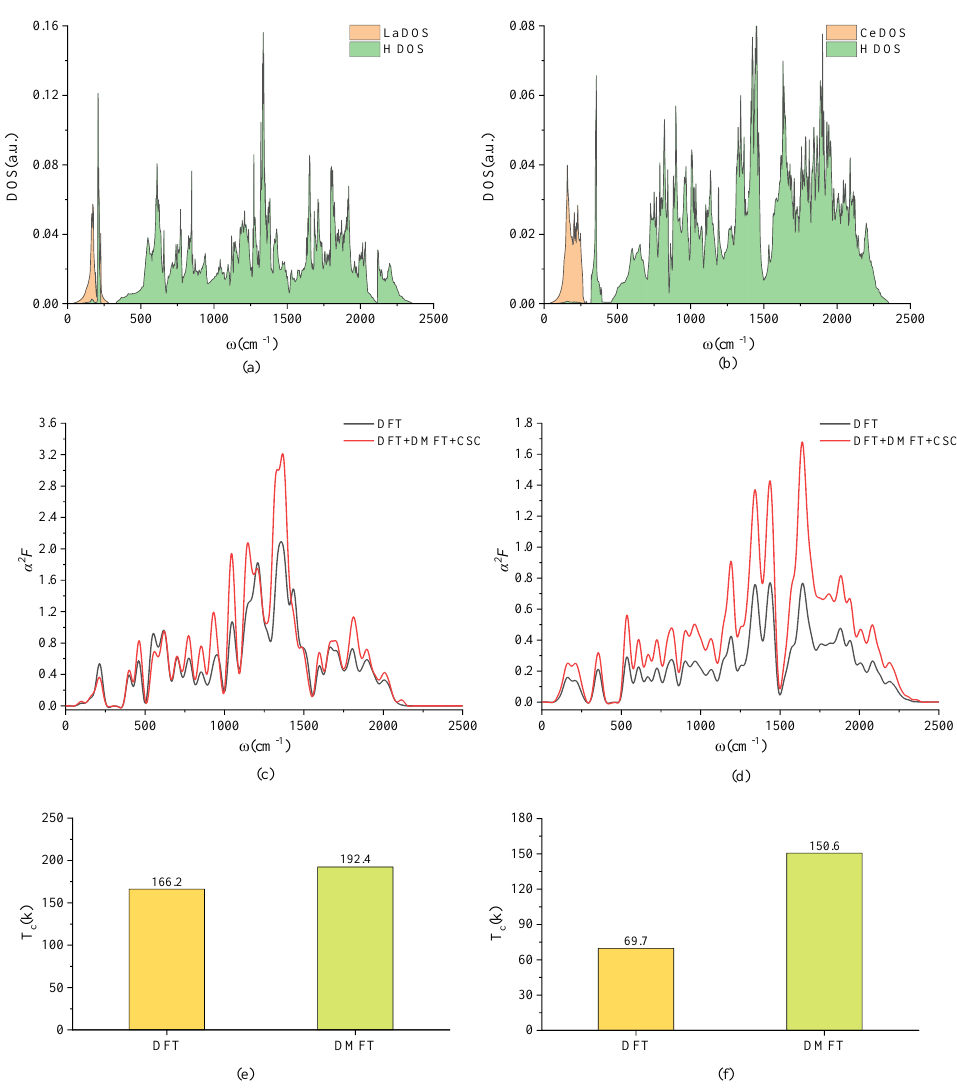
Figure 1. Many-body corrections to the superconducting temperature. We report ( a ) phonon density of states for LaH 16 ; ( b ) phonon density of states for CeH 16 ; ( c , d ) Eliashberg function α 2 F ( ω ) for LaH 16 and CeH 16 ; the spectral weight at the Fermi level is obtained at different levels of approximation: (i) DFT PBE (black line) and (ii) with the full-charge self-consistent formalism (DFT+DMFT+CSC, red line); ( e , f ) The superconducting temperature T c obtained by the Allen and Dynes formalism for LaH 16 and CeH 16 at 250 GPa. We obtain a theoretical estimate for LaH 16 as T c = 166.2 K by DFT and T c = 192.4 K by DMFT, as well as a theoretical estimate for CeH 16 as T c = 69.7 K by DFT and T c = 150.6 K by DMFT. The full-charge self-consistent DMFT provides a large increase of the superconducting temperature, and the physical value of the Hund’s coupling for La and Ce is U = 6 eV and J = 0.6 eV. All calculations were performed in the P6/mmm phase of LaH 16 and CeH 16 at 250